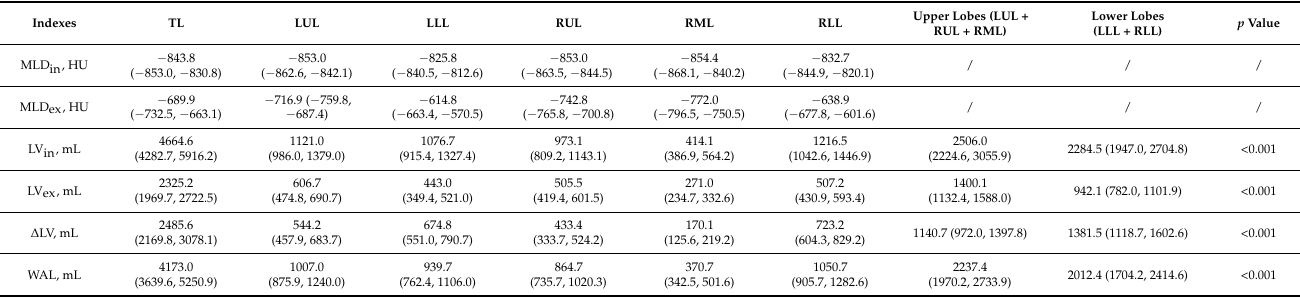
Table 2. The paired inspiratory–expiratory chest CT quantitative results of the total lung and each